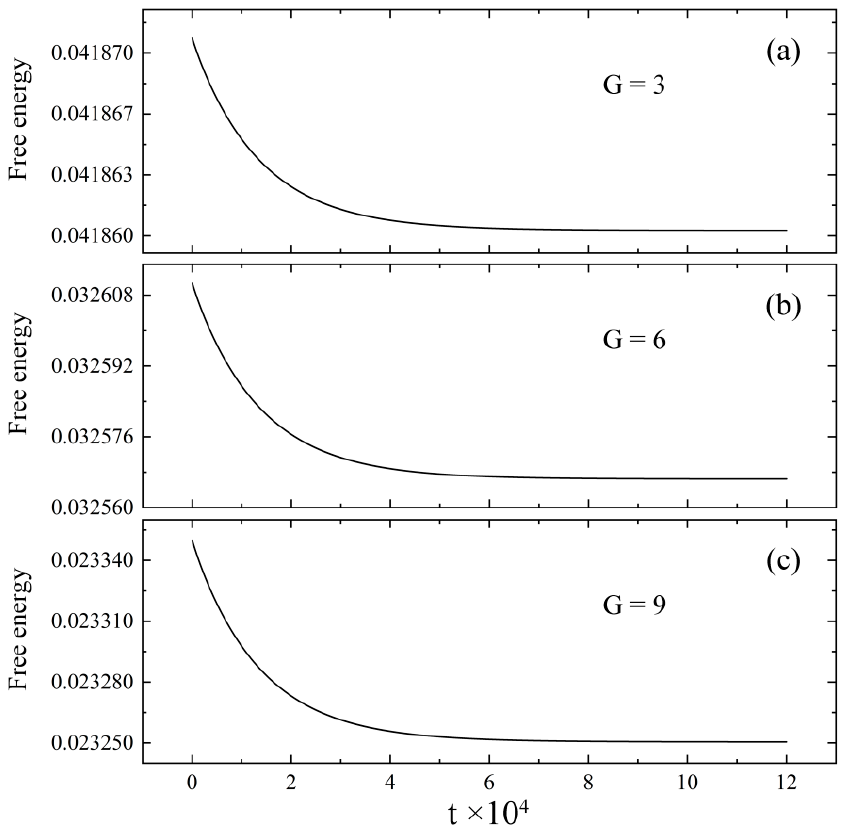
Figure 3. Change in the free energy in samples during the homogeneous liquid is equilibrated under a supergravity field with ( a ) G = 3, ( b ) G = 6, and ( c ) G = 9.